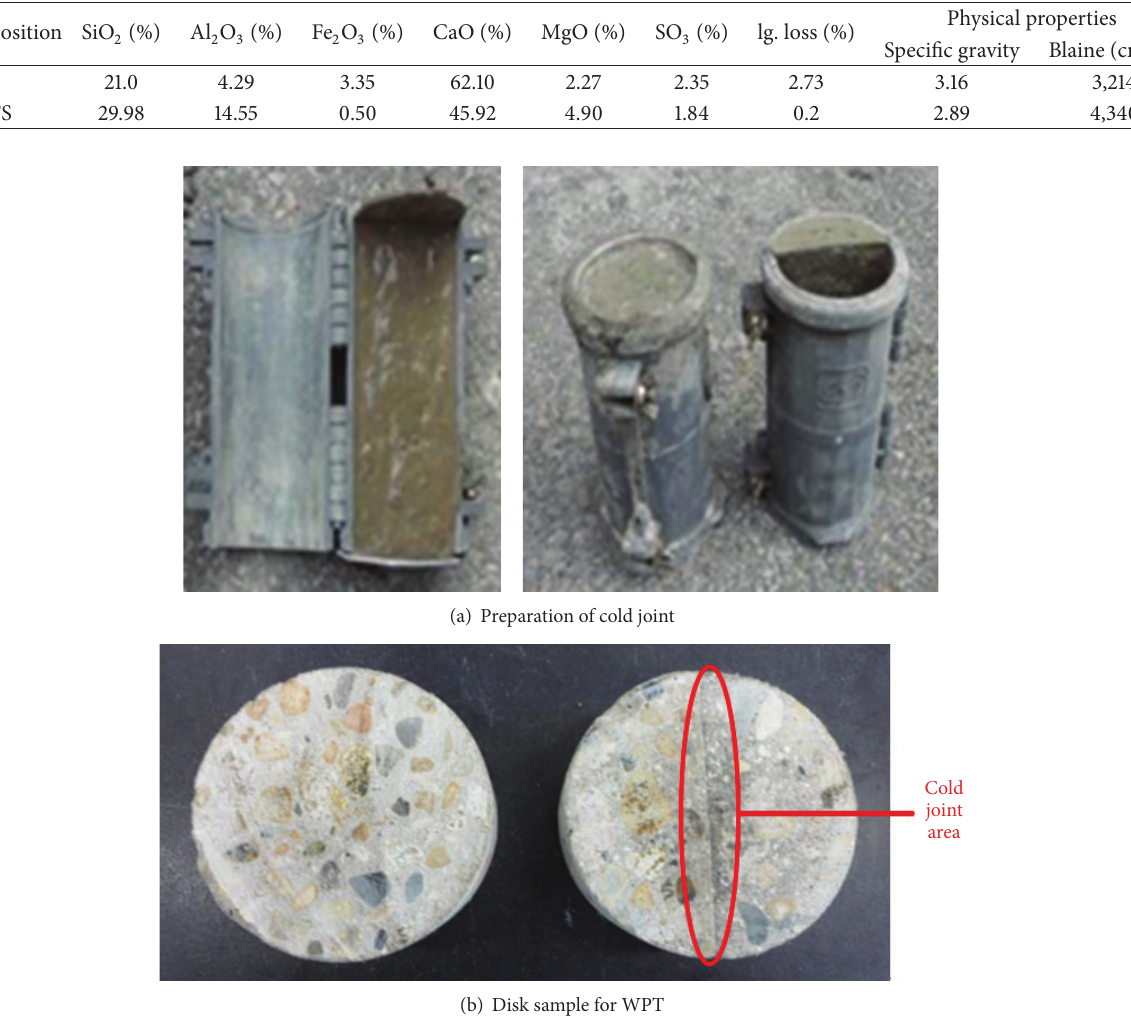
Figure 5: Photos for concrete samples with cold